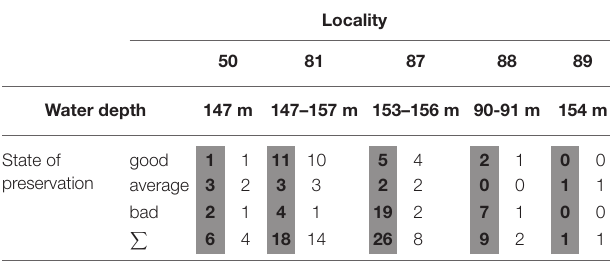
TABLE 1 | Summary table of the distribution of the collected specimens among the collection sites and preservation categories.